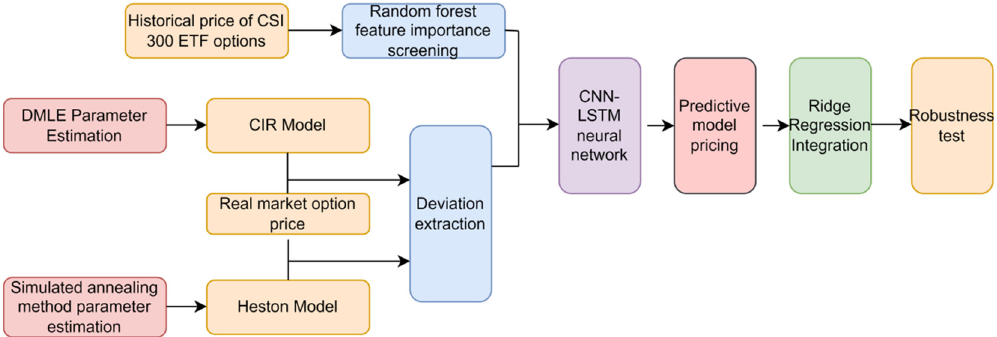
Figure 1. Overall architecture.